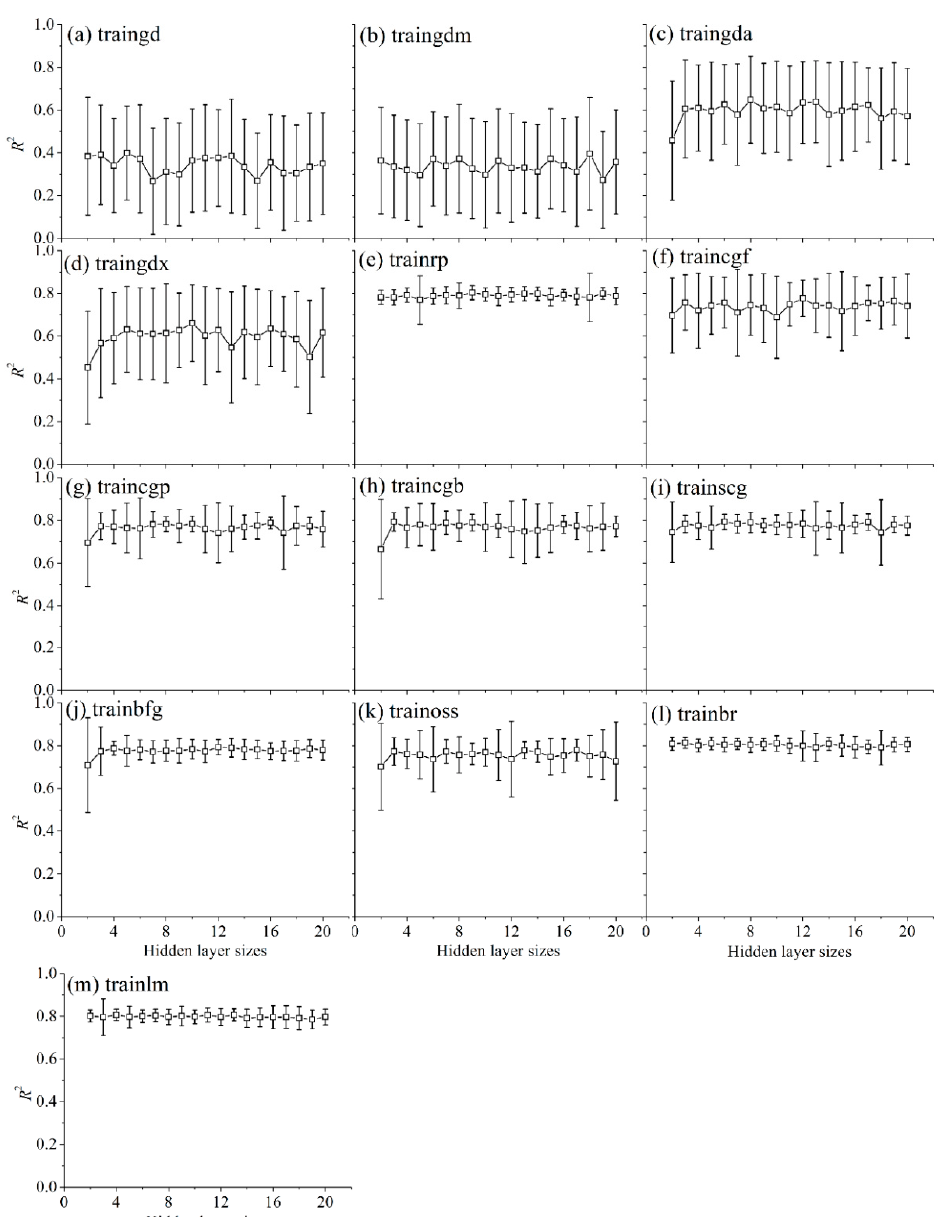
Figure 4. Performance of BPNN for LNC estimation based on the published fluorescence indices varying with hidden layer sizes for different training function. The black error bar represents one standard deviation of mean values.